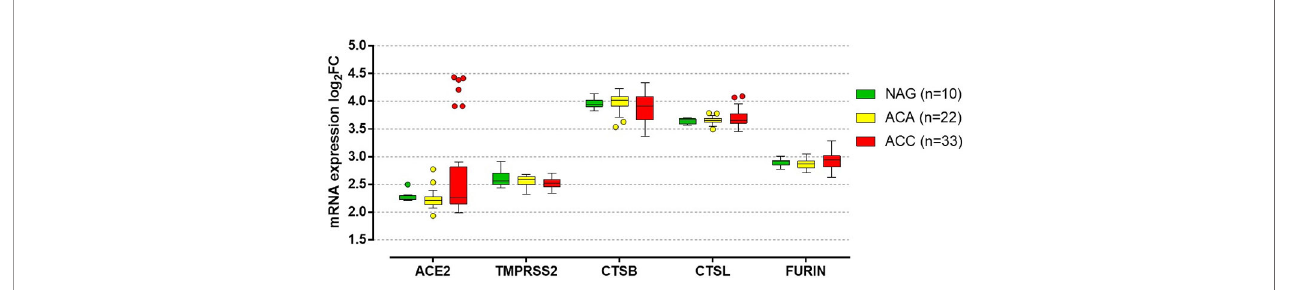
FIGURE 2 | In silico analysis of genes involved in the SARS-CoV-2 cell entry mechanism in normal adrenal gland and adrenocortical tumors. In silico analysis from the high density oligonucleotide array data published by Giordano et al. (14) (deposited in the National Center for Biotechnology Information ’ s Gene Expression Omnibus, accession number GSE10927), evaluating the quantile-normalized and then log transformed mRNA expression of ACE2 (encoding the angiotensin- converting enzyme 2), TMPRSS2 (encoding the transmembrane protease serine 2), CTSB (encoding cathepsin B), CTSL (encoding cathepsin L), and FURIN (encoding furin) in normal adrenal glands (NAG, n=10), adrenocortical adenomas (ACA, n=22) and adrenocortical carcinomas (ACC, n=33). No signi fi cant differences between NAG, ACA and ACC were observed in the expression of the evaluated genes ( per trend: P=0.29 for ACE2 , P=0.14 for TMPRSS2 , P=0.39 for CTSB , P=0.87 for CTSL , P=0.17 for FURIN ). In details, median log 2 fold chance (FC) of ACE was: 2.24 (2.22-2.30) for NAG, 2.21 (2.14-2.27) for ACA and 2.26 (2.15-2.82) for ACC. Median